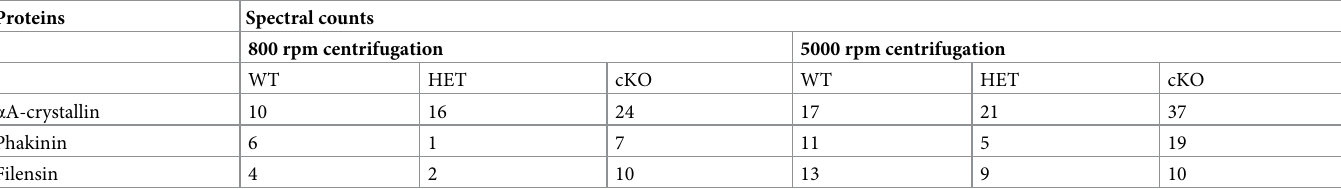
Table 4. Spectral counts in α A-crystallin, phakinin and filensin during mass spectrometric analysis. Proteins